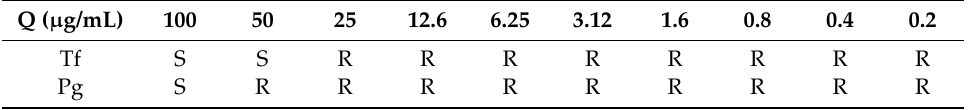
Table 2. MIC study of Quercetin against periodontal pathogens.